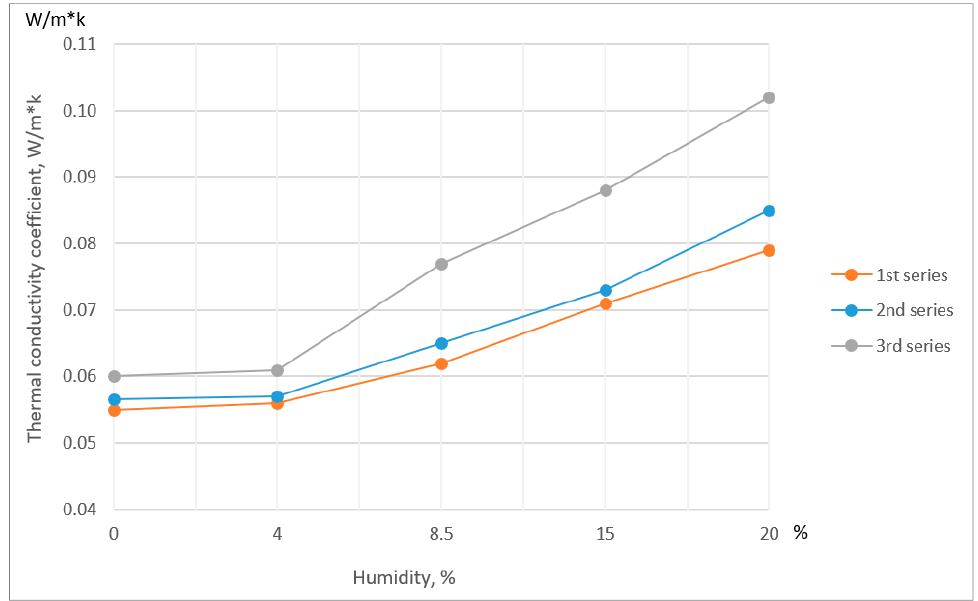
Figure 5. Thermal conductivity depending on the moisture content.